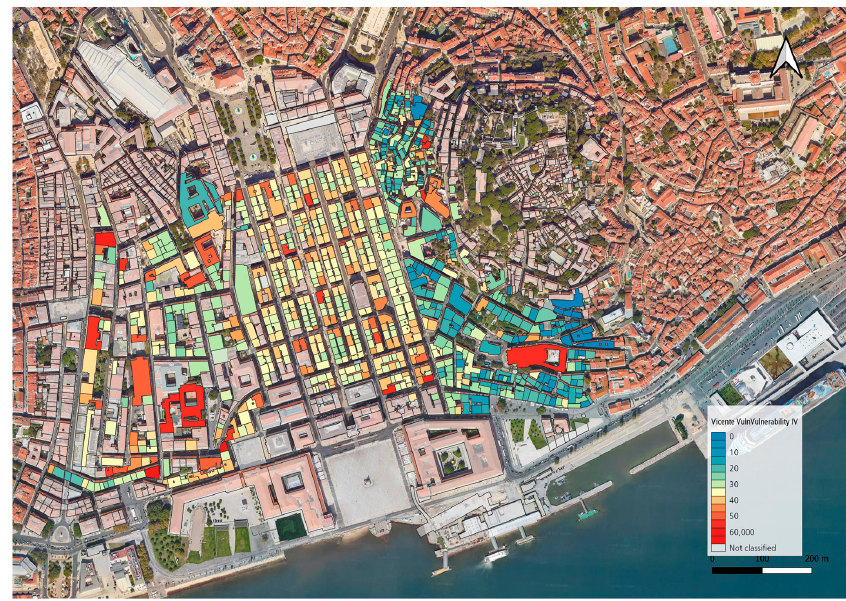
Figure 10. Vulnerability index calculated according to the Vicente method (2011).